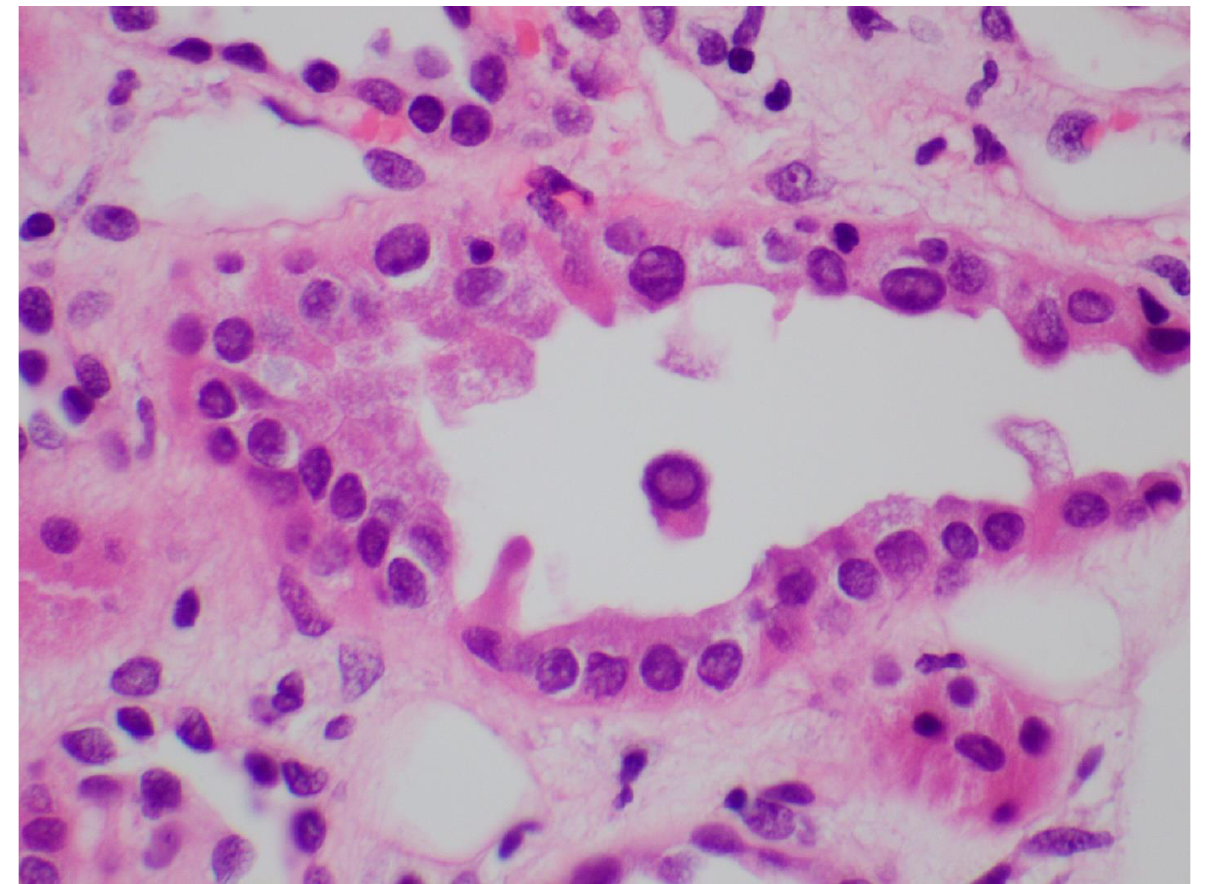
Figure 3. A tubular lumen containing sloughed epithelial cells with a viral intranuclear inclusion. H&E 600×.